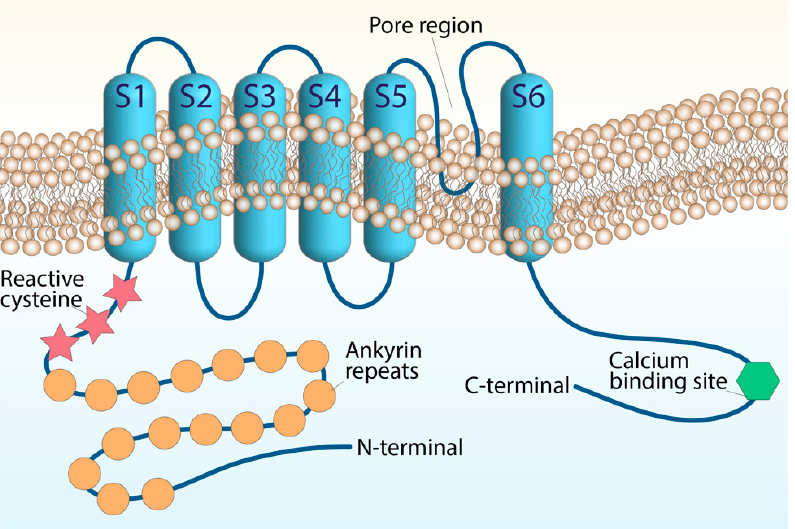
Figure 1. Structure of the TRPA1 channel. The TRPA1 architecture containing six transmembrane domains and intracellular N- and C-terminals. The transmembrane S5–S6 forming the central pore and selectivity filter. The reactive cysteine residues are within the N-terminal domain, along with the N-terminal ankyrin repeats, and the calcium-binding region is within the C-terminal.